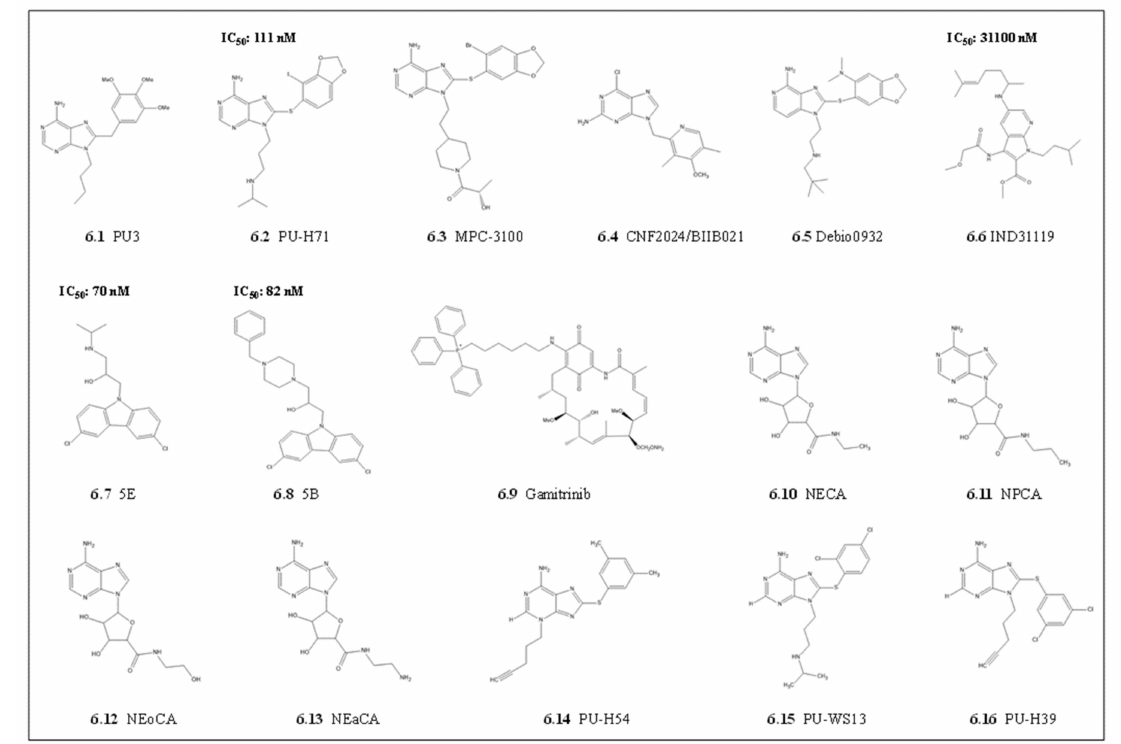
Figure 6. The purines and other derivatives as potential P. falciparum Hsp90 inhibitors. The chemical structures of the compounds are shown with their respective numbering. 6.1 PU3. 6.2 PU-H71. 6.3 MPC-3100. 6.4 CNF2024/BIIB021.